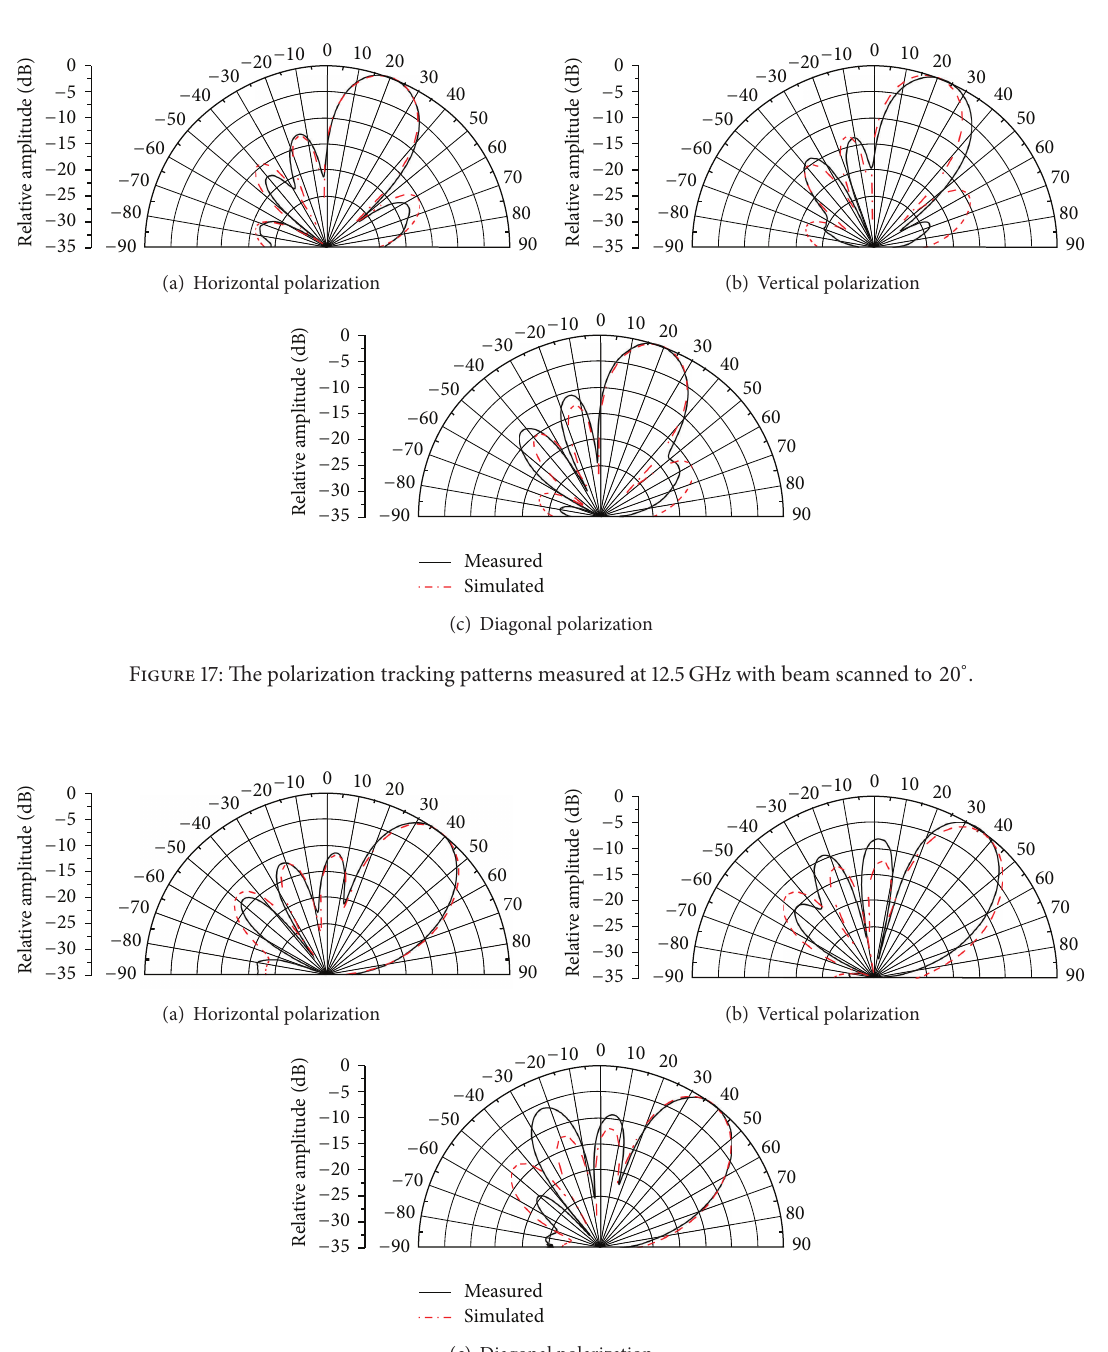
polarization tracking array prototype during beam